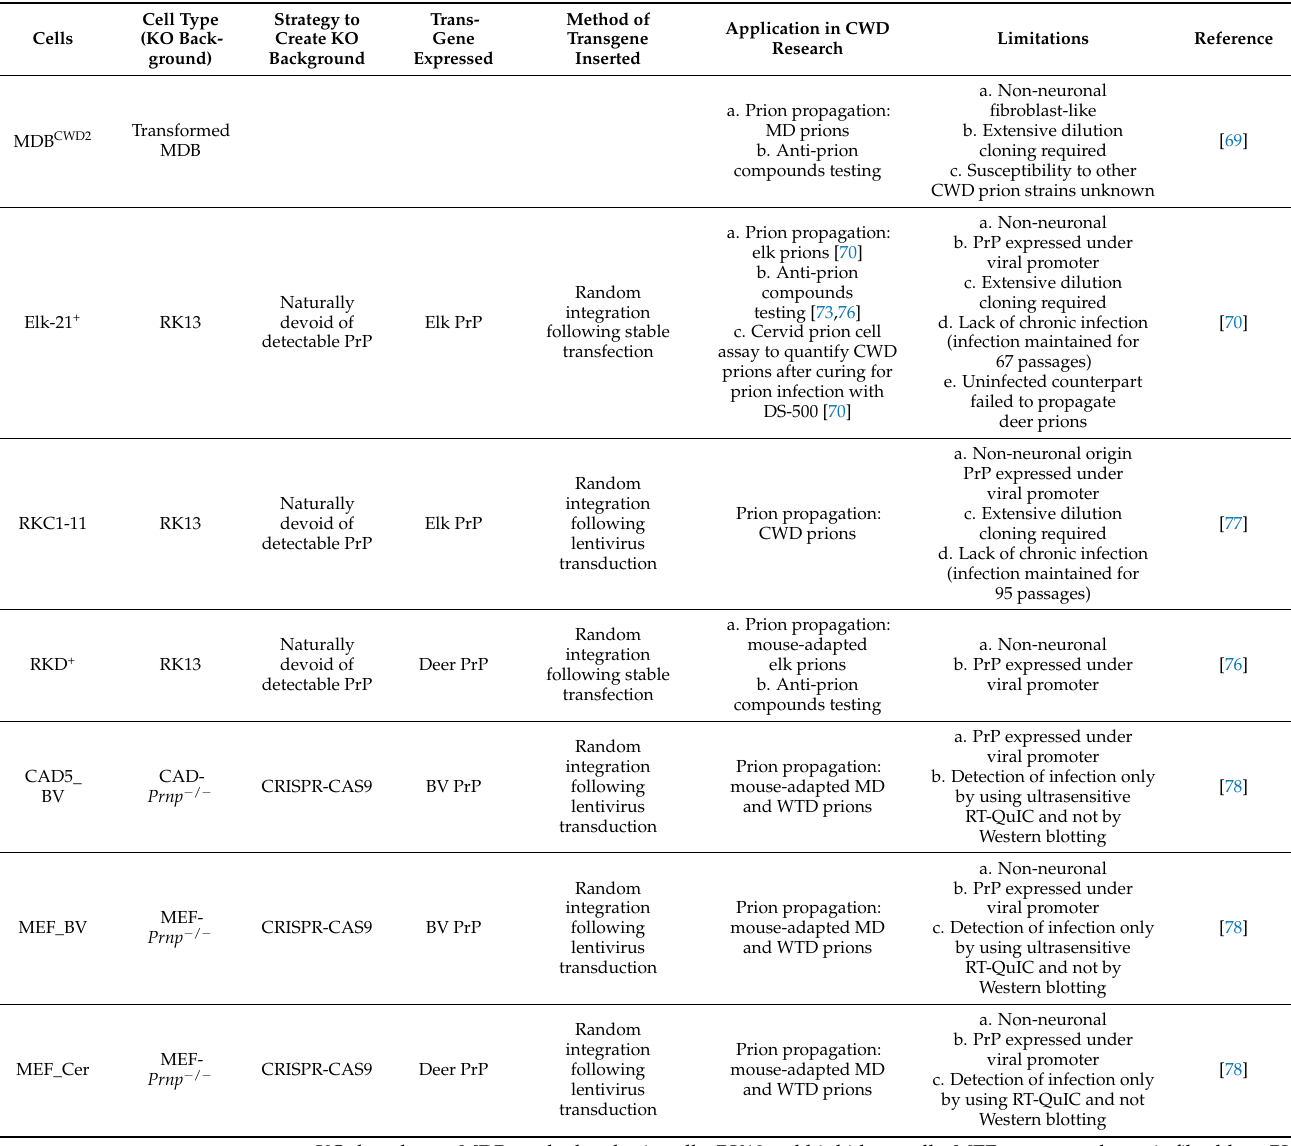
Table 1. Cell culture models of CWD